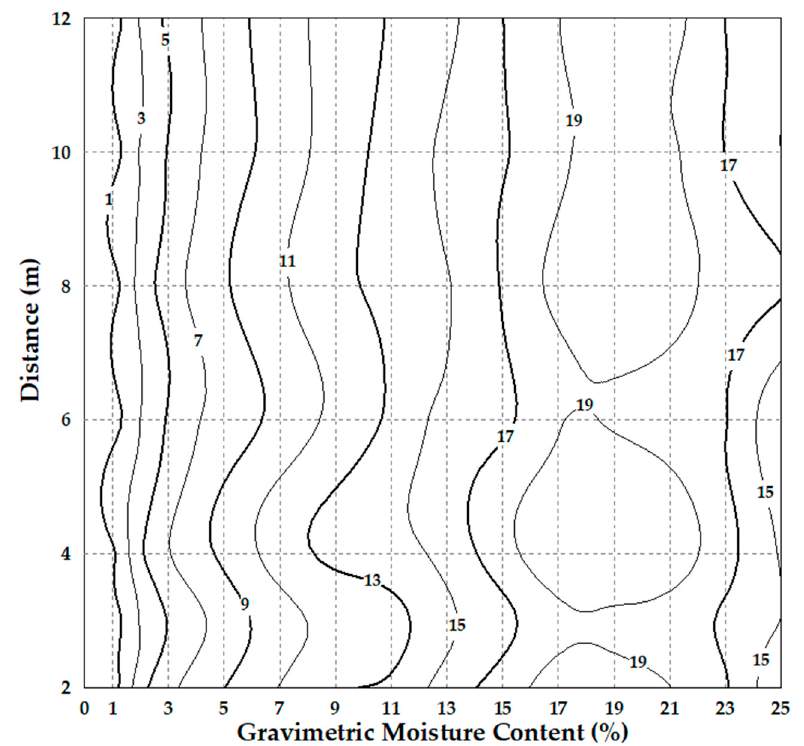
Figure 7. Contour lines of the derived moisture versus the distance (2–12 m) and the gravimetric moisture contents (0–25%) based on the distance experiments. Table 4. Derived samples’ moisture contents based on the data of the distance experiments. Moisture (%)